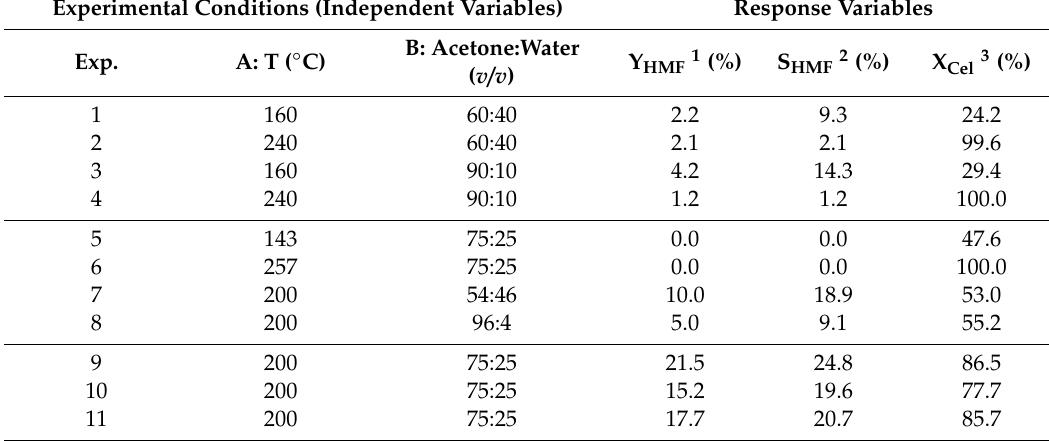
Table 3. Central composite rotatable design (CCRD) matrix for optimizing reaction conditions of cellulose conversion into 5-hydroxymethylfurfural